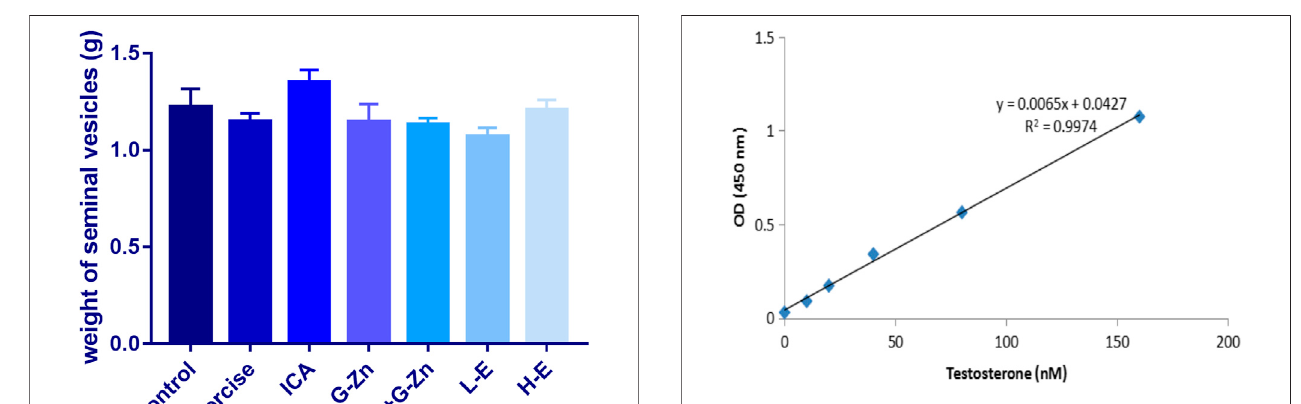
FIGURE 11 | Testosterone standard curve.